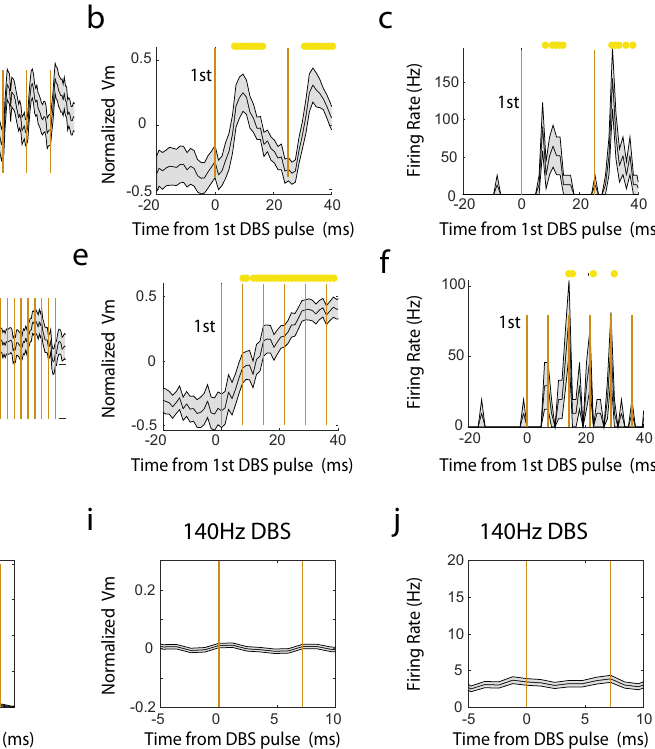
Fig. 3 | Individual electrical pulse evoked Vm and fi ring rate modulations are DBS frequency dependent. a The population-averaged Vm trace before, during and after 40Hz DBS with the pulse onset times indicated by the golden vertical lines. Green box indicates the time windows where zoom-in versions are shown in b,e .ShadedarearepresentsSEM.Vmiscalculatedasthe fl uorescenceateachtime pointdividedbytheaverageamplitudeofallspikesdetectedinarecordingsession foragivenneuron.DBS-inducedVmchangeswerecomputedasnormalizedVmby subtracting the mean of the Vm during the prestimulation baseline period. b The population-averaged Vm trace ( n =22 neurons) around 40Hz DBS onset. Shaded